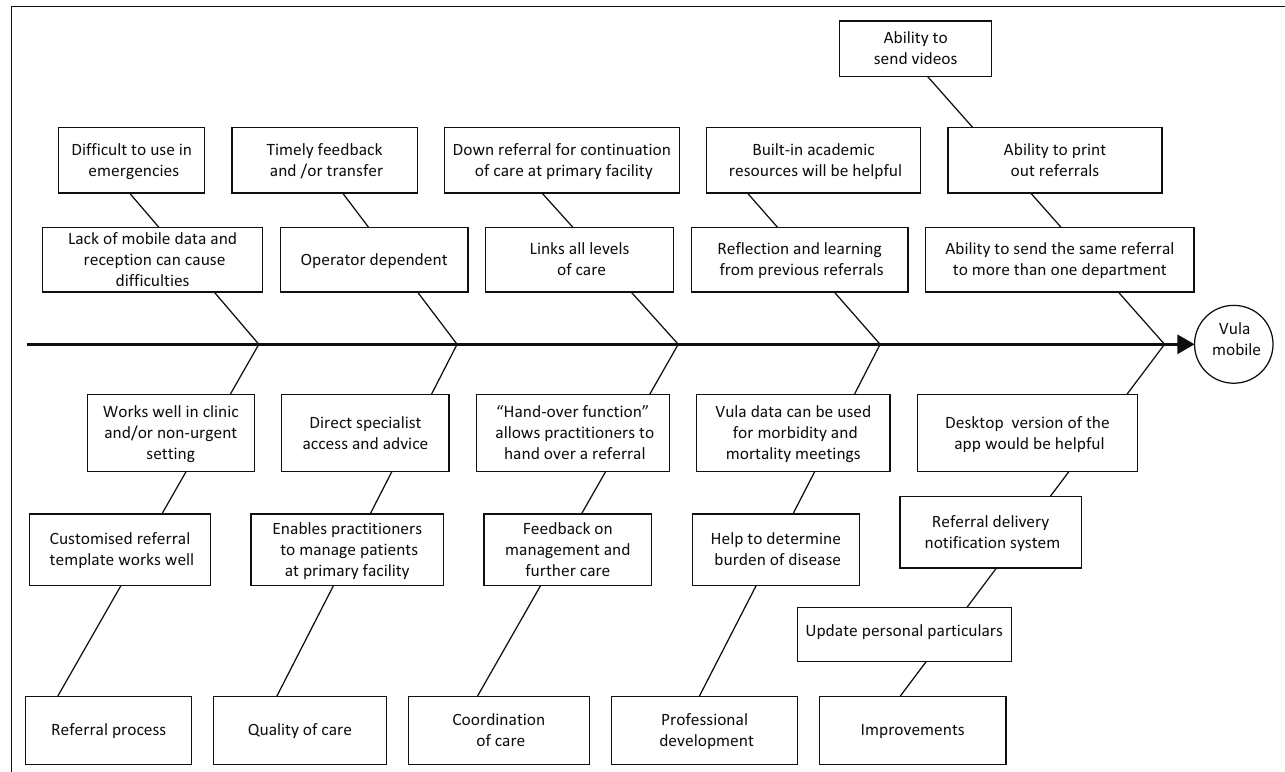
FIGURE 1: Fishbone diagram summarising key